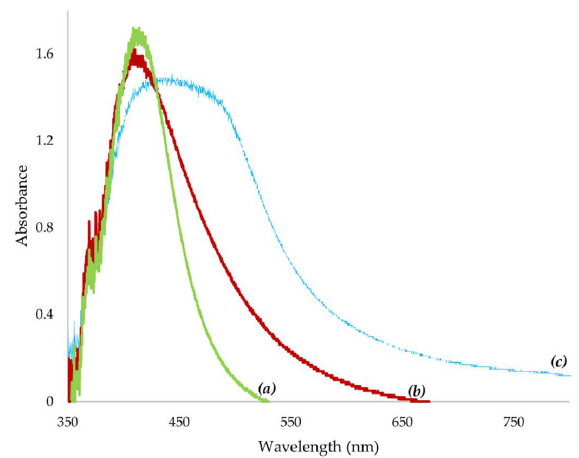
Figure 2. UV–visible absorption spectra of silver nanoparticles and their combinations with antibiotics. UV–visible spectrum showed the maximum absorbance at ( a ) 412 nm for AgNPs, ( b ) 410 nm for AgNPs + AMP and ( c ) 450 nm for AgNPs + AMK. AMP: Ampicillin. AMK: Amikacin.